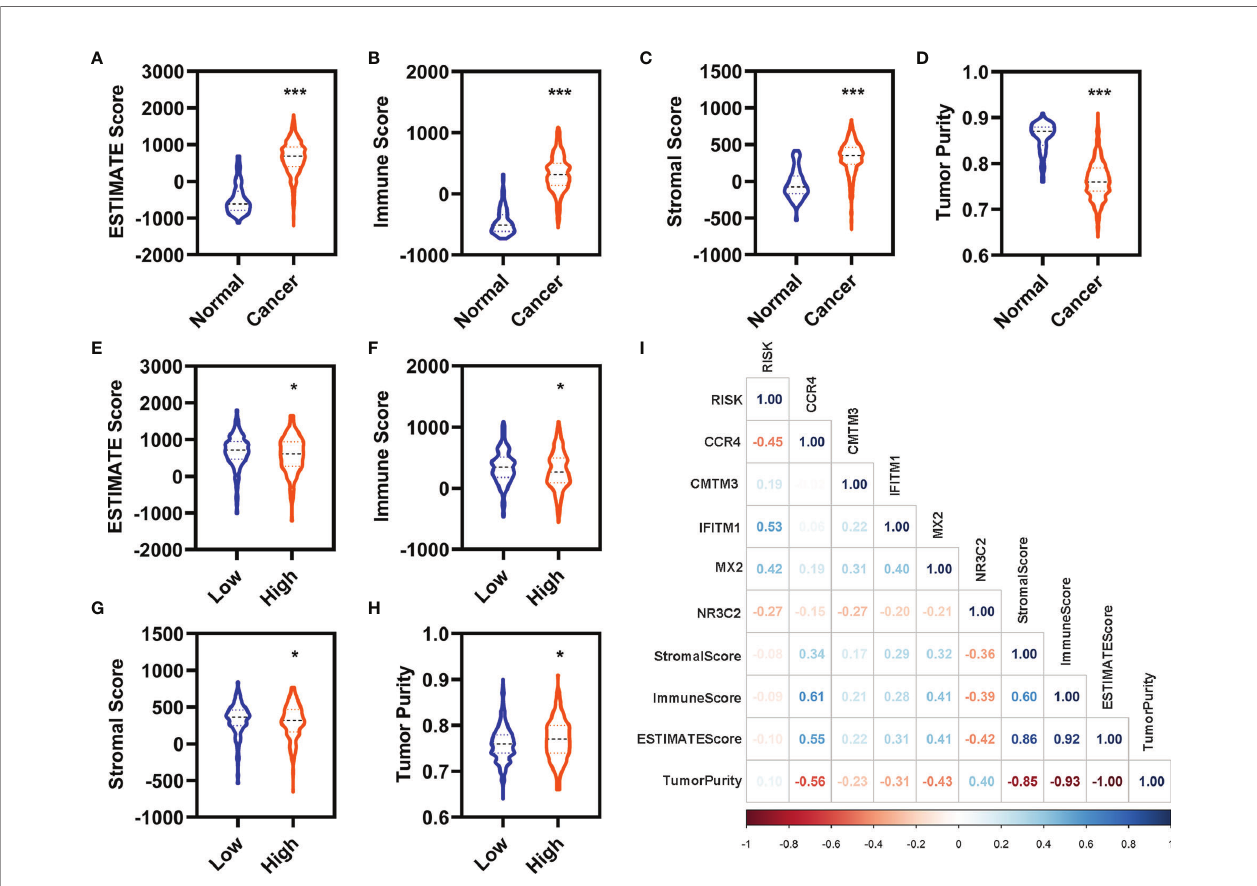
FIGURE 5 | Correlation analyses with the immune. (A – D) Differentially expressed analyses for the ESTIMATE (A) , immune (B) , stromal (C) , and tumor purity (D) between the normal and patients with KIRC in the entire cohort. (E – H) Differentially expressed analyses for the ESTIMATE (E) , immune (F) , stromal (G) , and tumor purity (H) between the patients with KIRC with low-risk value and high-risk value in the entire cohort. (I) Correlation analyses of these fi ve FI-DEGs and risk value with the immune in the entire cohort. N (normal) = 72, N (cancer) = 530. N (low) = 336, N (high) =194. *p < 0.05, ***p <